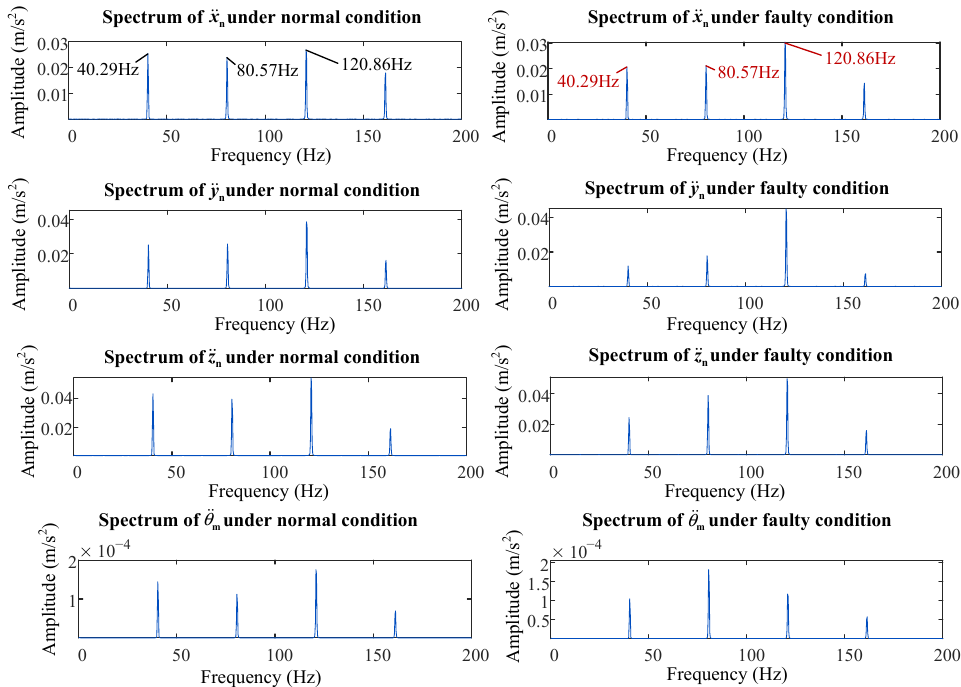
Figure 13. Frequency spectra of the nut or motor output shaft-related parameters under normal and faulty